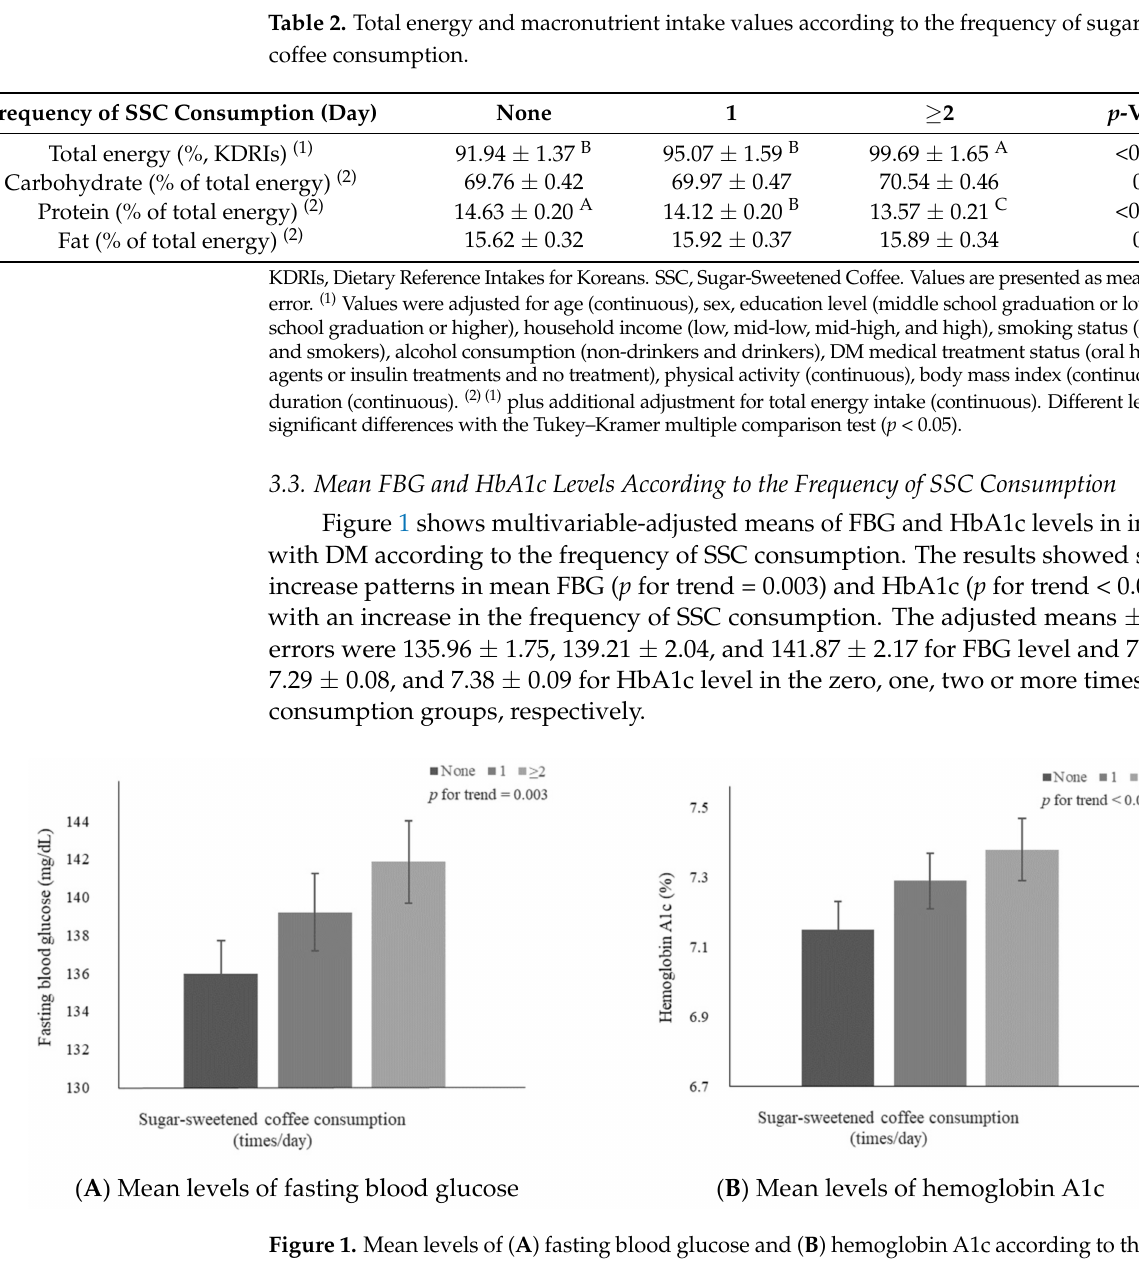
Figure 1. Mean levels of ( A ) fasting blood glucose and ( B ) hemoglobin A1c according to the frequency of sugar-sweetened coffee consumption. Values were adjusted for age (continuous), sex, education level (middle school graduation or lower and high school graduation or higher), household income (low, mid-low, mid-high, and high), smoking status (non-smokers and smokers), alcohol consumption (non-drinkers and drinkers), physical activity (continuous), DM medical treatment status (oral hypoglycemic agents or insulin treatments and no treatment), body mass index (continuous), DM duration (continuous), and total energy intake